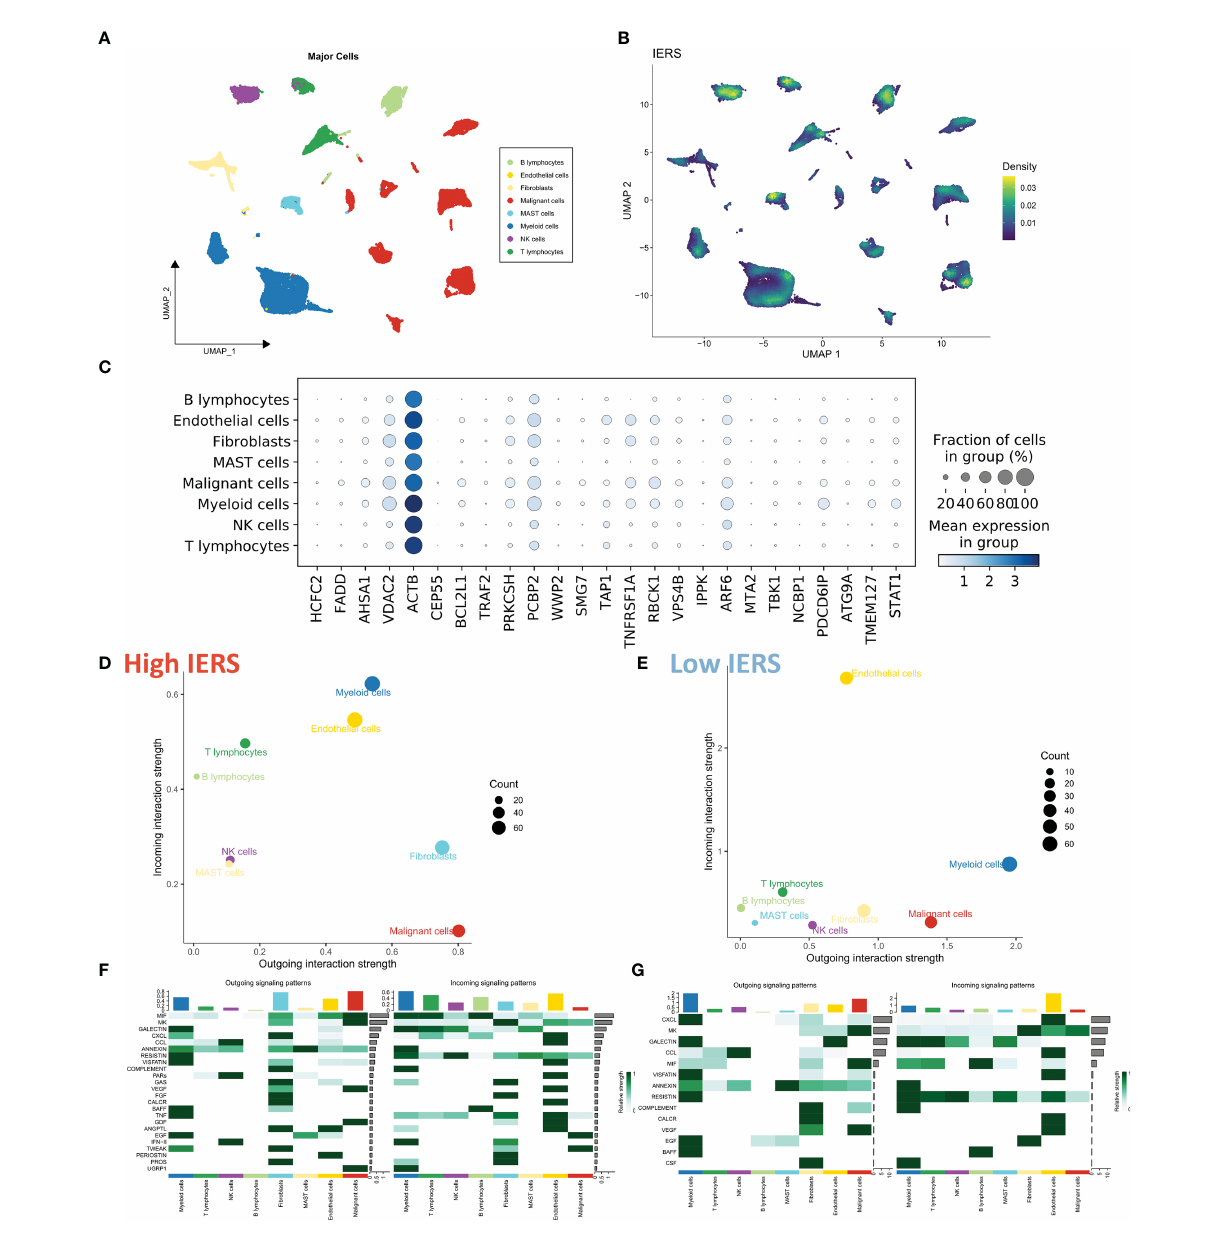
FIGURE 4 Evaluation of IERS at single-cell resolution (A) Eight identi fi ed cell clusters are shown based on Umap descending. (B) M Distribution of IERS in different cell clusters. (C) Expression of IERS model genes in different cell clusters. (D) Overall cellular communication intensity in high IERS cells. (E) Overall cellular communication intensity in low IERS cells. (F) Speci fi c communication pathways between high IERS cells. (G) Speci fi c communication pathways between low IERS